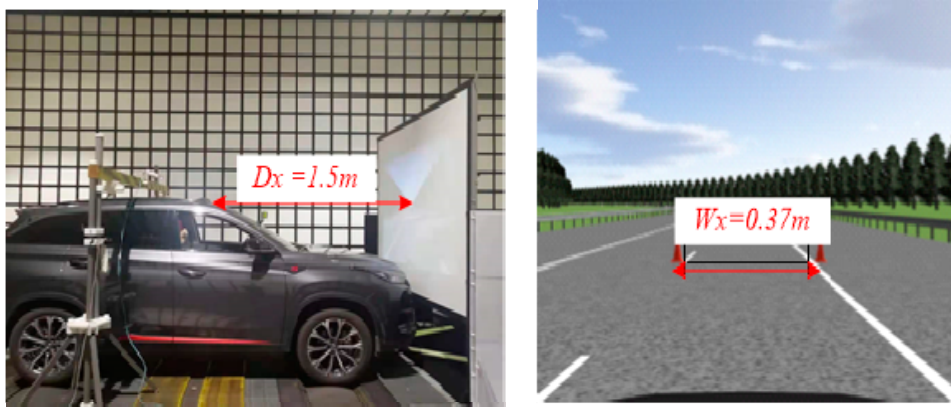
Figure 7. Adjustment for activating the LDW function, distance from the camera to screen ( left ), and calibrated road width on the screen ( right ).